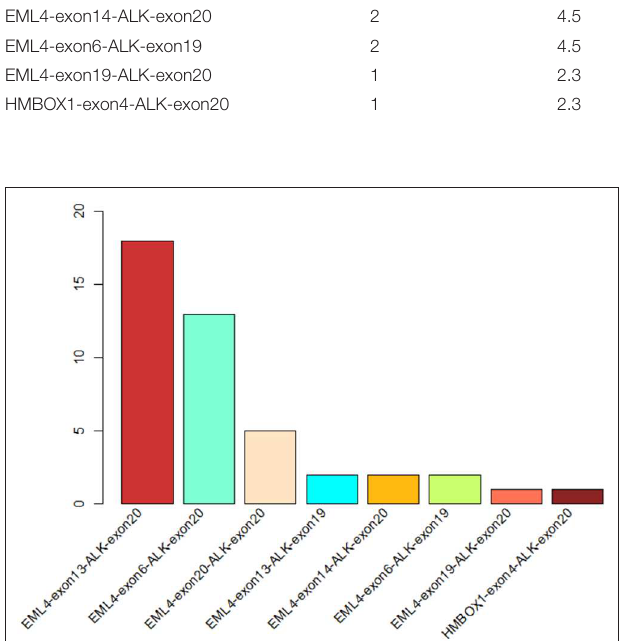
FIGURE 1 | The statistics of different ALK rearrangement forms. The number of each ALK fusion pattern identified in 44 NSCLC patients are shown in the